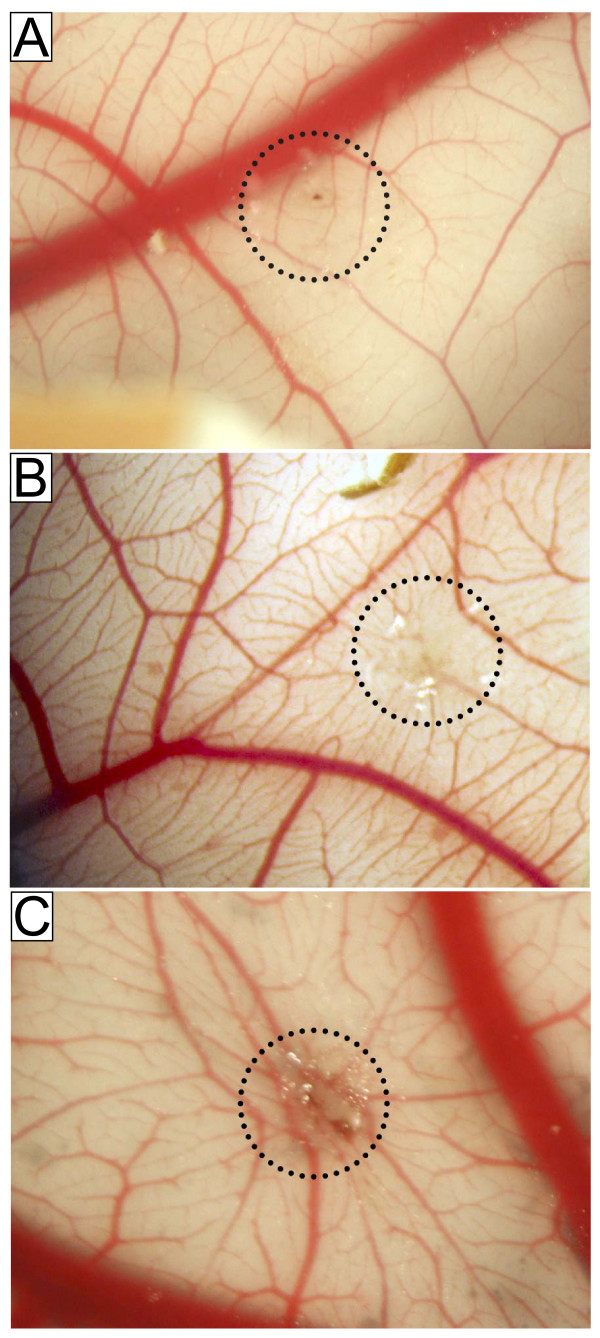
CRP stimulated spoke wheel blood vessel formation in the CAM assay. A, Negative control (score 0.5); B, CRPdt-treated (5 μg/ml; score 2.0); C, Positive control, FGF-2-treated (100 ng/ml) (score 3.0). Spoke wheel patterns can be seen in both CRP- and FGF-2-treated samples originating from the pellet (designated by dotted circles). Experiments were performed twice. A representative example of 5 CAM's used per experiment is shown.